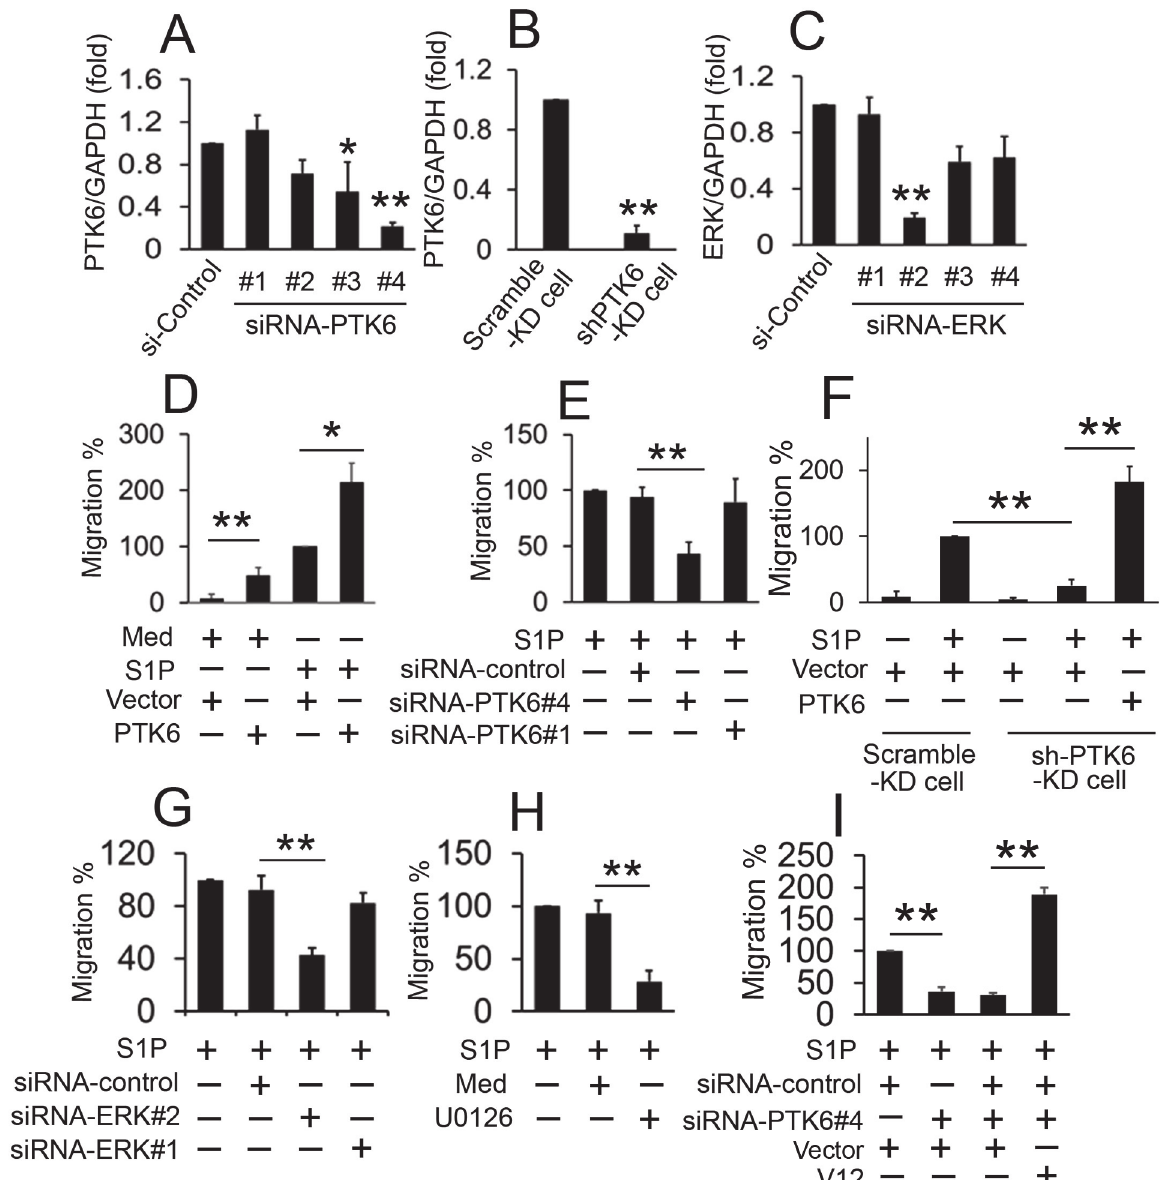
Fig 2. Effect of PTK6 and ERK1/2 on S1P-induced migration of ML-1 cells. (A) ML-1 cells were transfected with siRNA-control or indicated siRNA-PTK6s for 48 hours prior to real-time RT-PCR analysis. (B) Real-time RT-PCR analysis was used to determine the expression of PTK6 2 days after infection of ML-1 cells with lentiviral vector pLKO.1 carrying shRNA for PTK6 (shPTK6-KD cell) or control shRNA (Scramble-KD cell). (C) Experiments were performed as in A except cells were transfected with indicated siRNA-ERKs. (D) ML-1 cells were transfected with pcDNA3.1-Mock (empty vector) or pcDNA3.1-PTK6 for 24 hours. Then, cells were treated with or without S1P (100 nM, 30 min) and allowed to migrate towards serum for 12 hours. (E) Experiments were performed as in D except that the indicated siRNA-PTK6 were used. (F) Scramble-KD cells and shPTK6-KD cells were transfected with the indicated expression plasmids for 24 hours and treated with or without S1P (100 nM, 30 min) and allowed to migrate towards serum for 12 hours. (G) Experiments were performed as in D, except the indicated siRNA-ERK were used. (H) ML-1 cells were treated with UO126 (10 μ M) or DMSO (Med) for 12 hours and treated with S1P (100 nM, 30 min) and allowed to migrate towards serum for 12 hours. (I) ML-1 cells were transfected with the indicated plasmids and siRNA for 24 hours and treated with S1P (100 nM, 30 min) and allowed to migrate towards serum for 12 hours. In the real-time RT-PCR experiments, the control was designated as 1. All experiments were repeated at least three times with similar results. Bar graphs represent means ± SD, n = 3 ( ** P < 0.01; * P < 0.05).